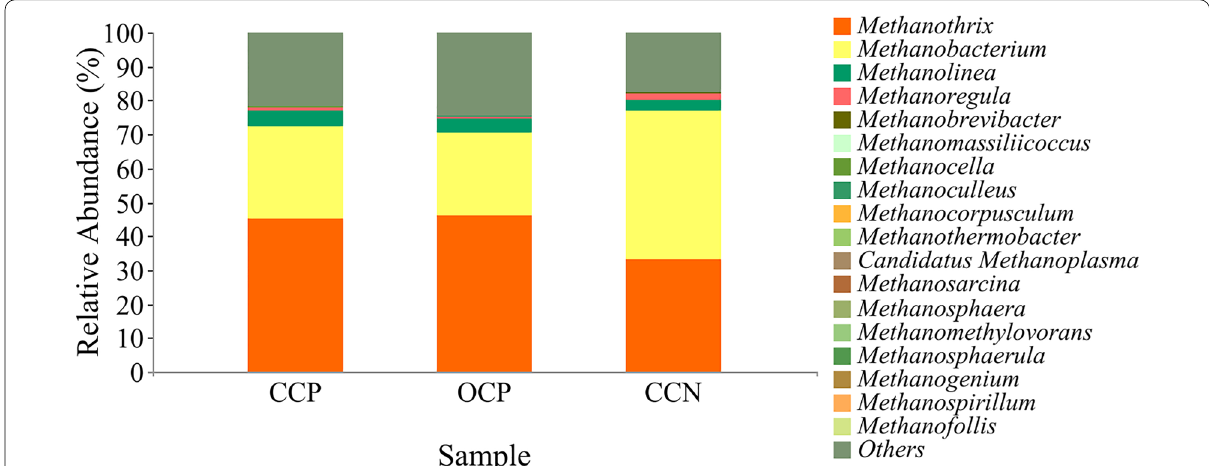
Fig. 8 Relative abundance of major genera in CCP, OCP and CCN under methanogenic primers. Genera with relative abundances below the top twenty are defined as “other”